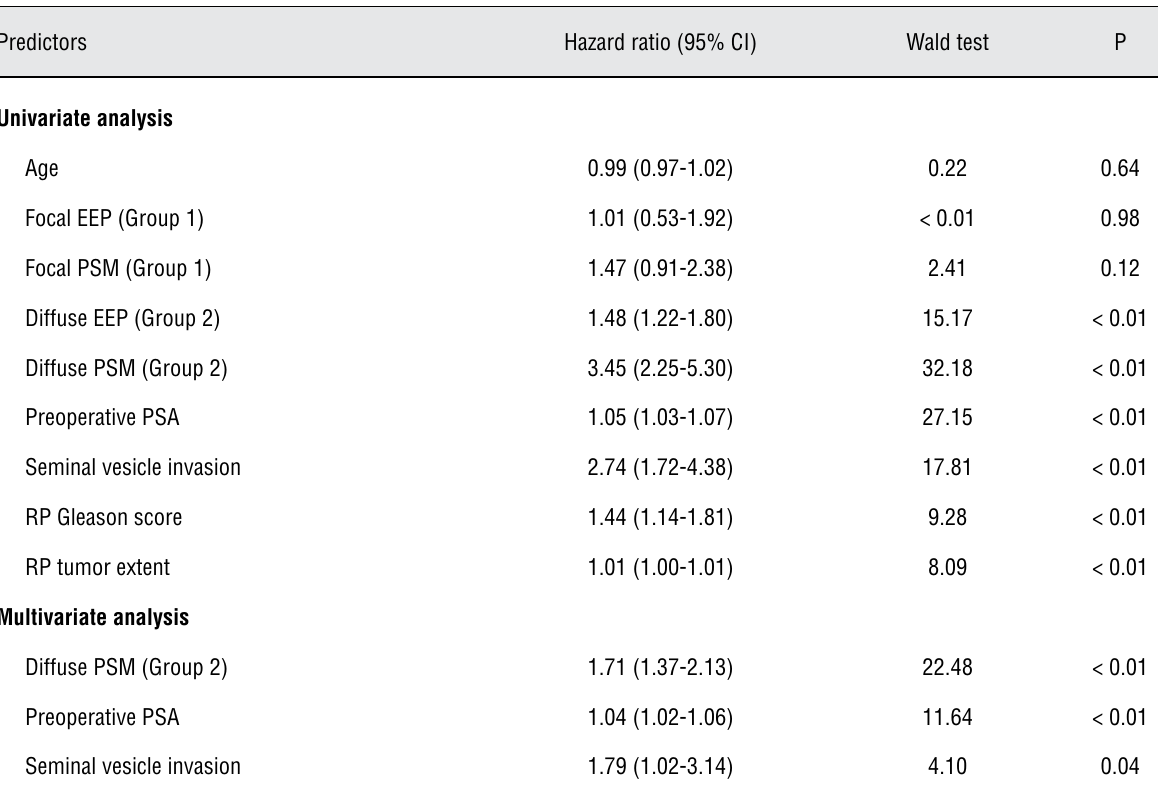
Table 3 - Cox proportional hazard analysis of several clinicopathological factors predicting time to biochemical recurrence following radical